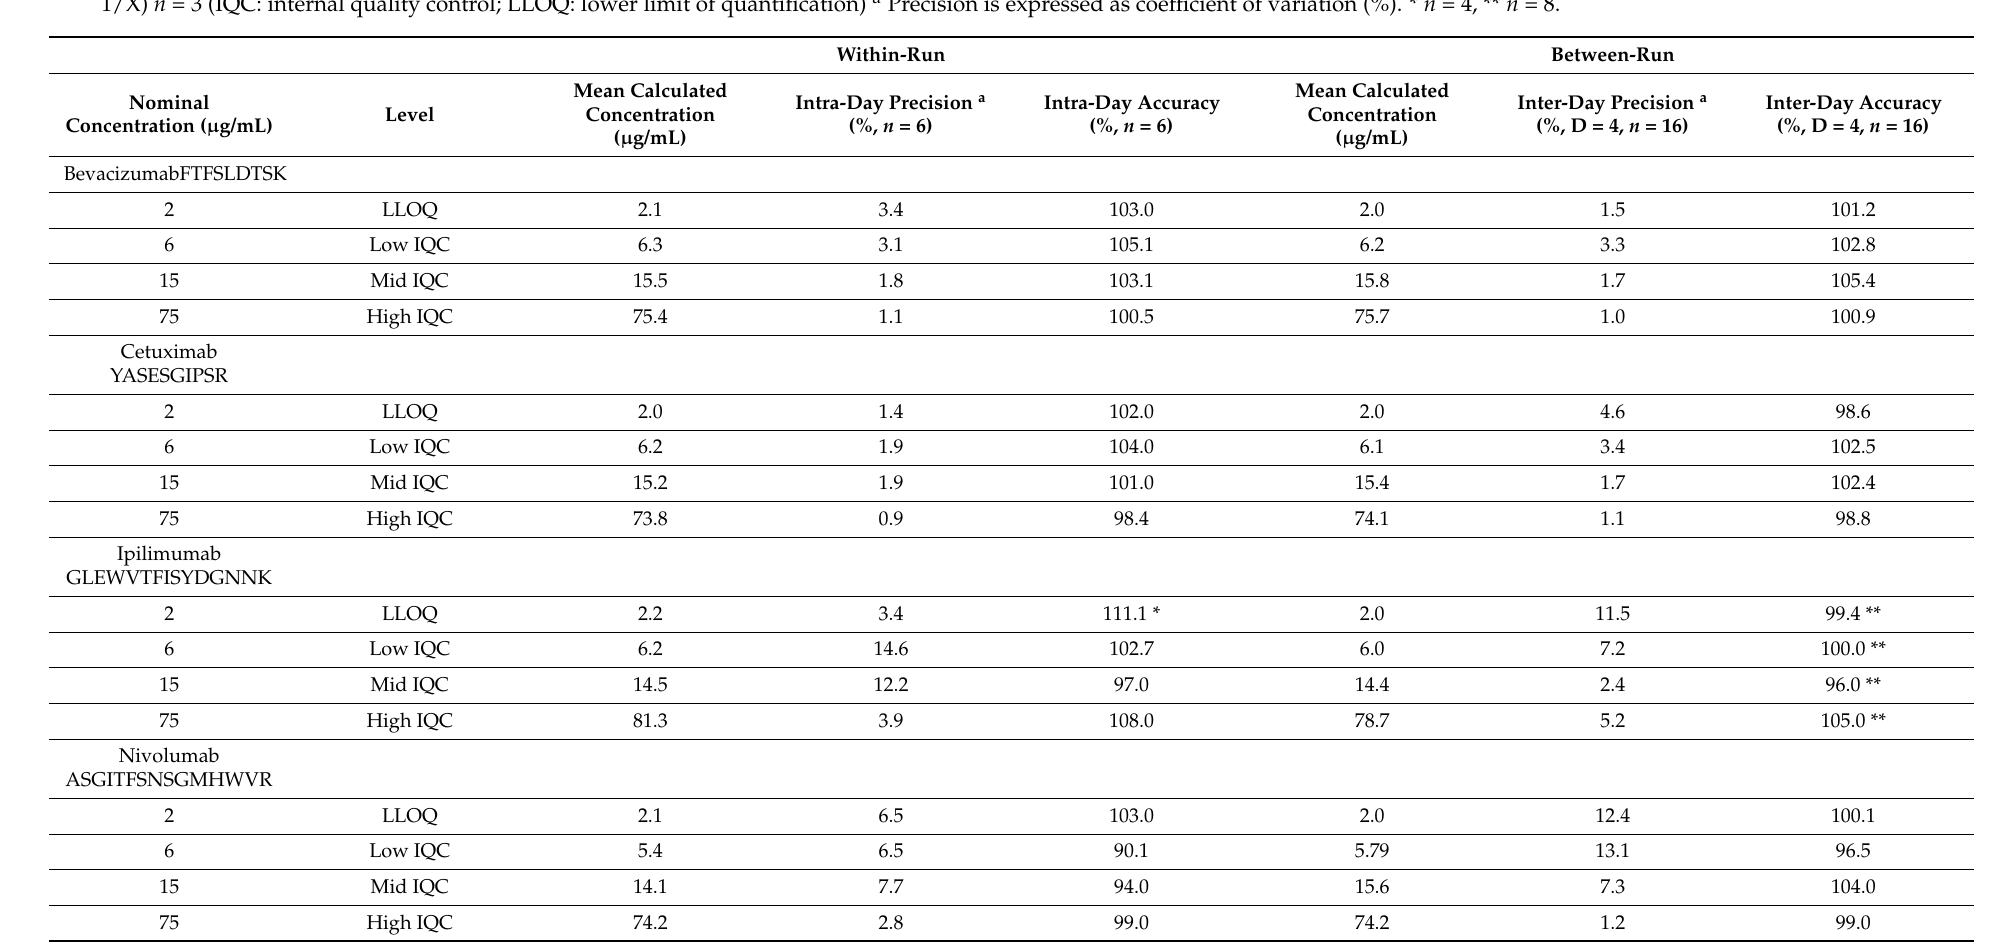
Table 1. Intra- and inter-assay accuracy and precision of OTDM1 monoclonal antibodies measured in plasma with mAbXmise kit. Results obtained with originator drugs (linear regression 1/X) n = 3 (IQC: internal quality control; LLOQ: lower limit of quantification) a Precision is expressed as coefficient of variation (%). * n = 4, ** n =